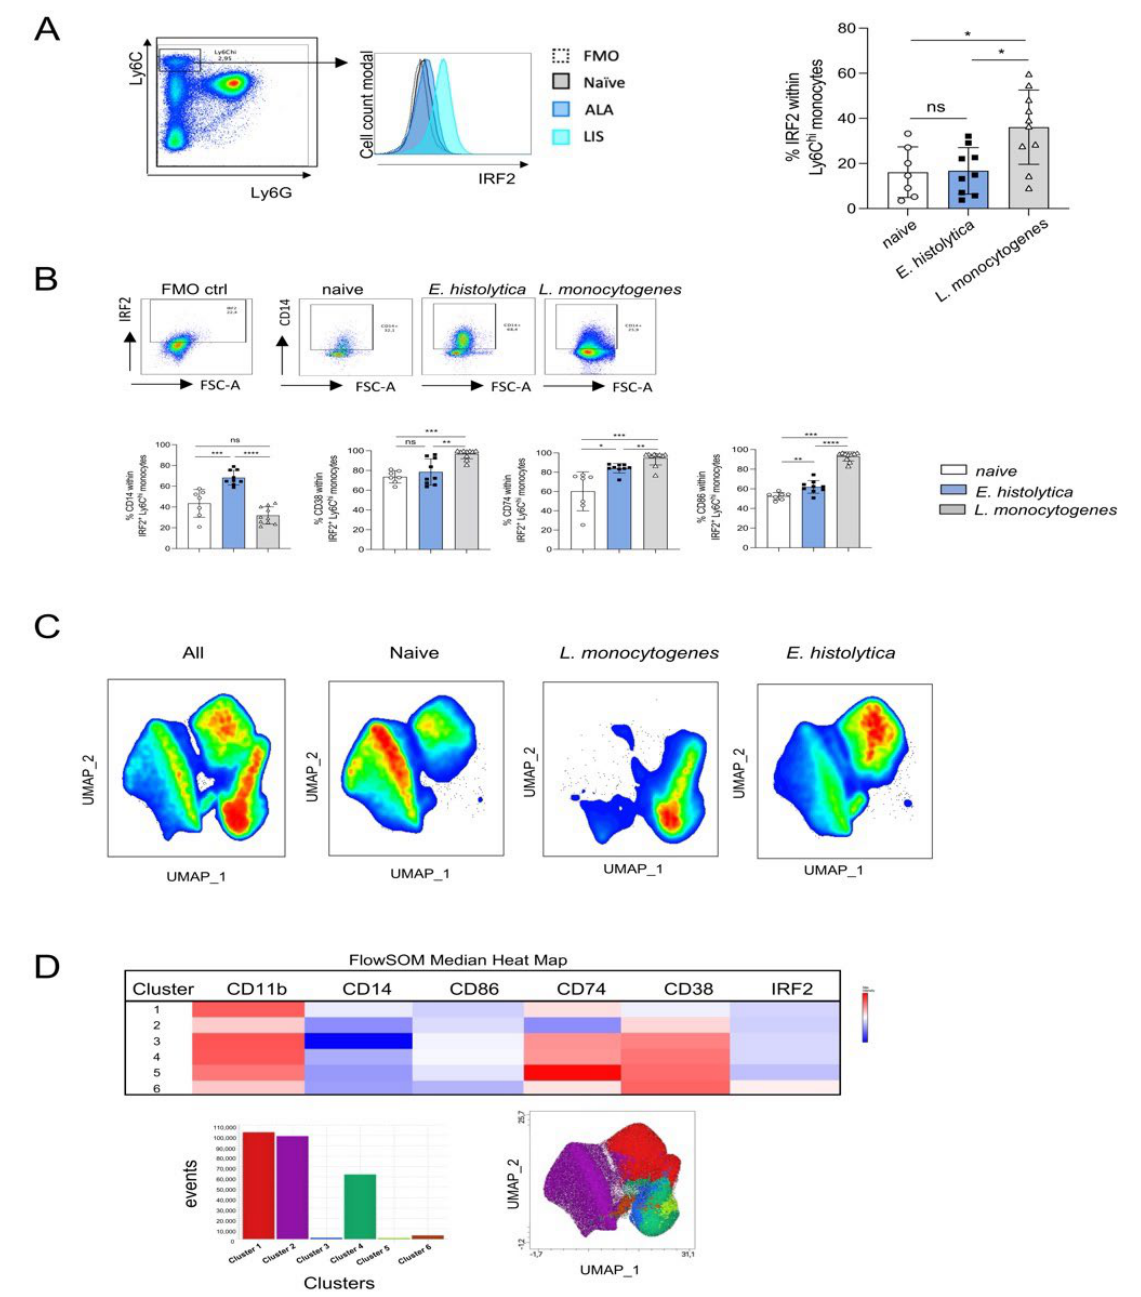
Figure 5. New Ly6C hi monocyte subsets identified according to expression of selected surface markers and IRF2. ( A ) Gating strategy, histogram, and percentage of IRF2 + Ly6C hi monocytes from livers of naïve mice and from E. histolytica - and L. monocytogenes -infected mice on day 3 post infecion. ( B ) Gating strategy (exemplary for CD14 + gated cells) based on the FMO control to determine CD14 + , CD38 + , CD74 + , and CD86 + monocytes within the IRF2 + Ly6C hi monocyte population from naïve mice and from both infection models on day 3 post infection. ( C ) UMAP plots of Ly6C hi monocytes (including CD14 + , CD86 + , CD74 + , CD38 + ) from naïve mice and from E. histolytica - and L. monocytogenes -infected mice (down sampled to 90,000 cells per sample). Six samples per source material were included in the analysis. ( D ) Cluster heatmap table showing surface marker and IRF2 expression by Ly6C hi monocytes, cluster events, and integration of cluster events in the UMAP plot (* p < 0.05; ** p < 0.01; *** p < 0.001; **** p < 0.0001; Mann-Whitney U